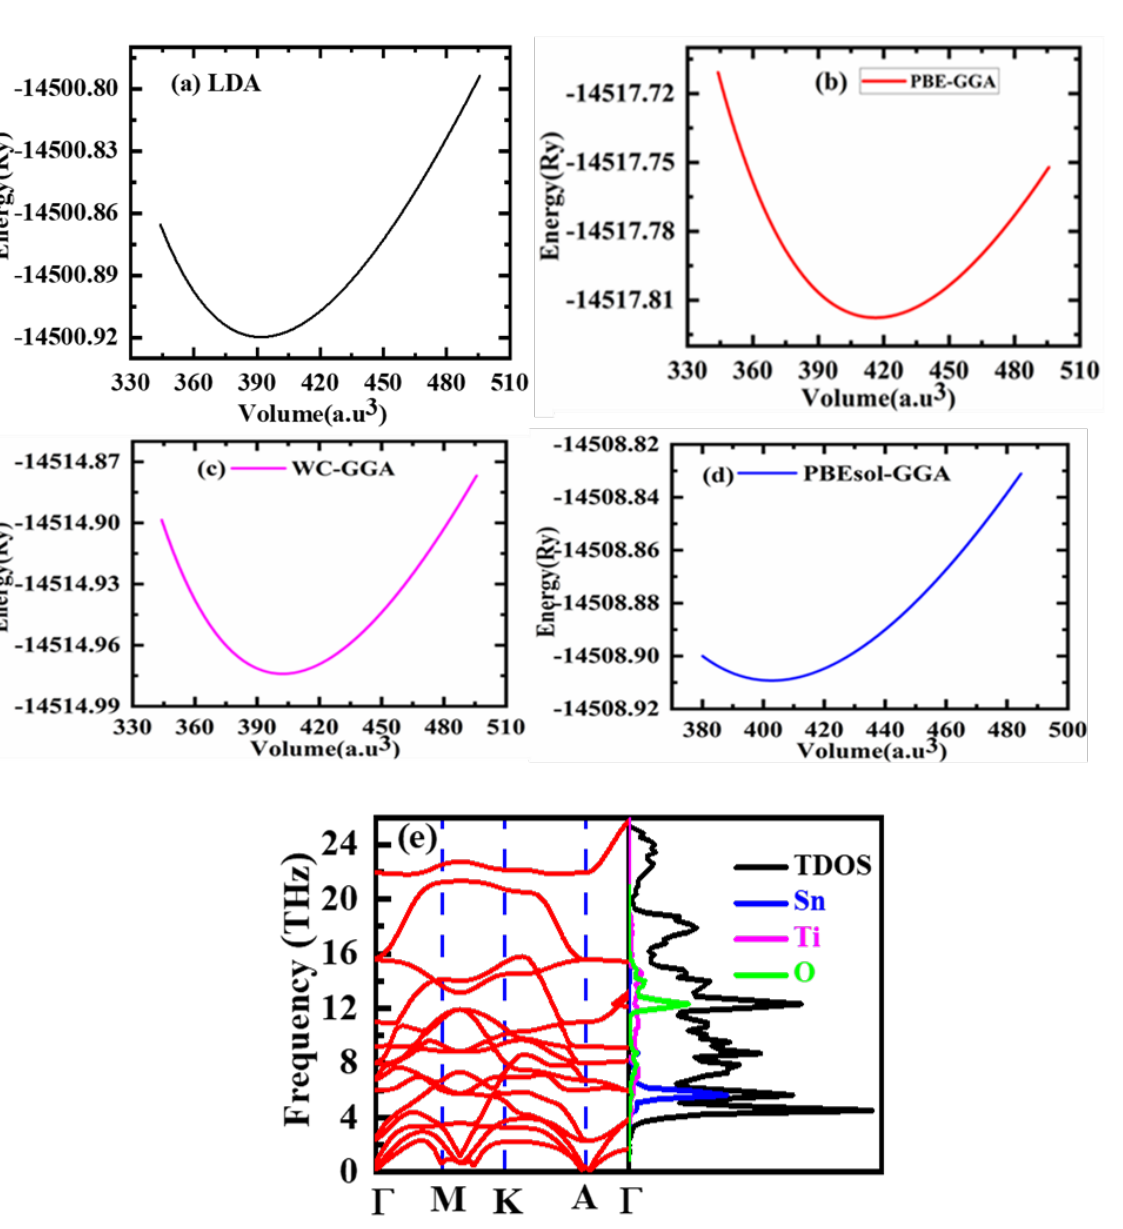
Figure 2. Variation in total energy with volume for cubic SnTiO 3 obtained using ( a ) LDA, ( b ) PBE- GGA, ( c ) WC-GGA, ( d ) PBEsol-GGA, and ( e ) the combined phonon dispersion and TDOS of SnTiO 3 compound.